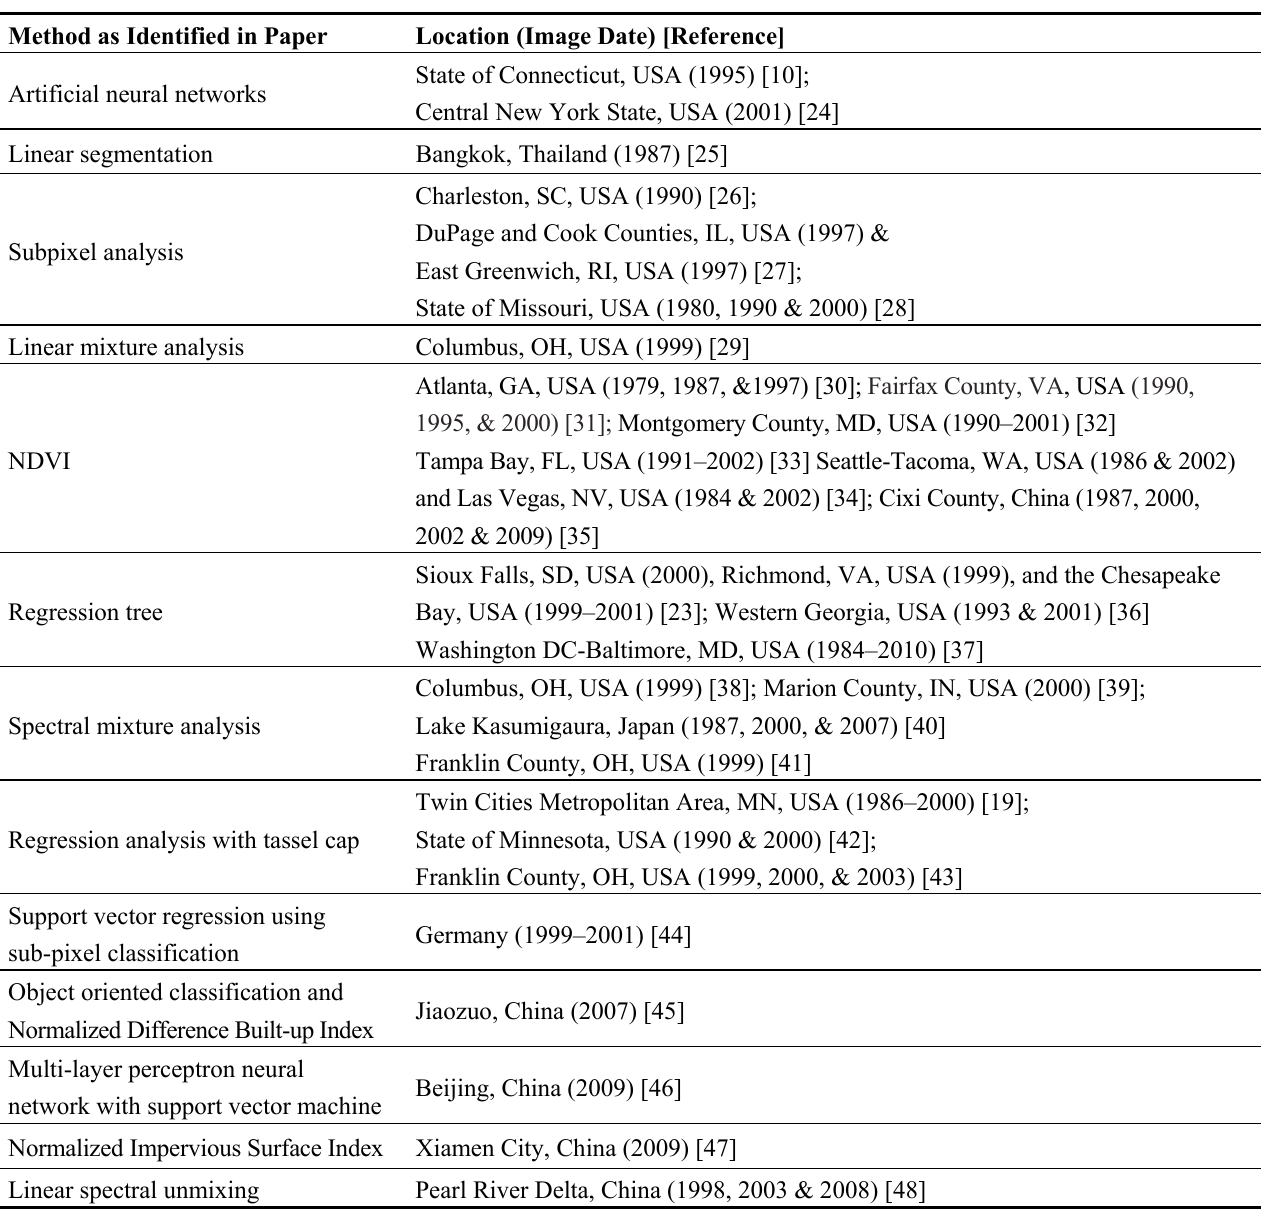
Table 1. Selected Studies, using Landsat imagery, that illustrate the variety of classification techniques to identify impervious